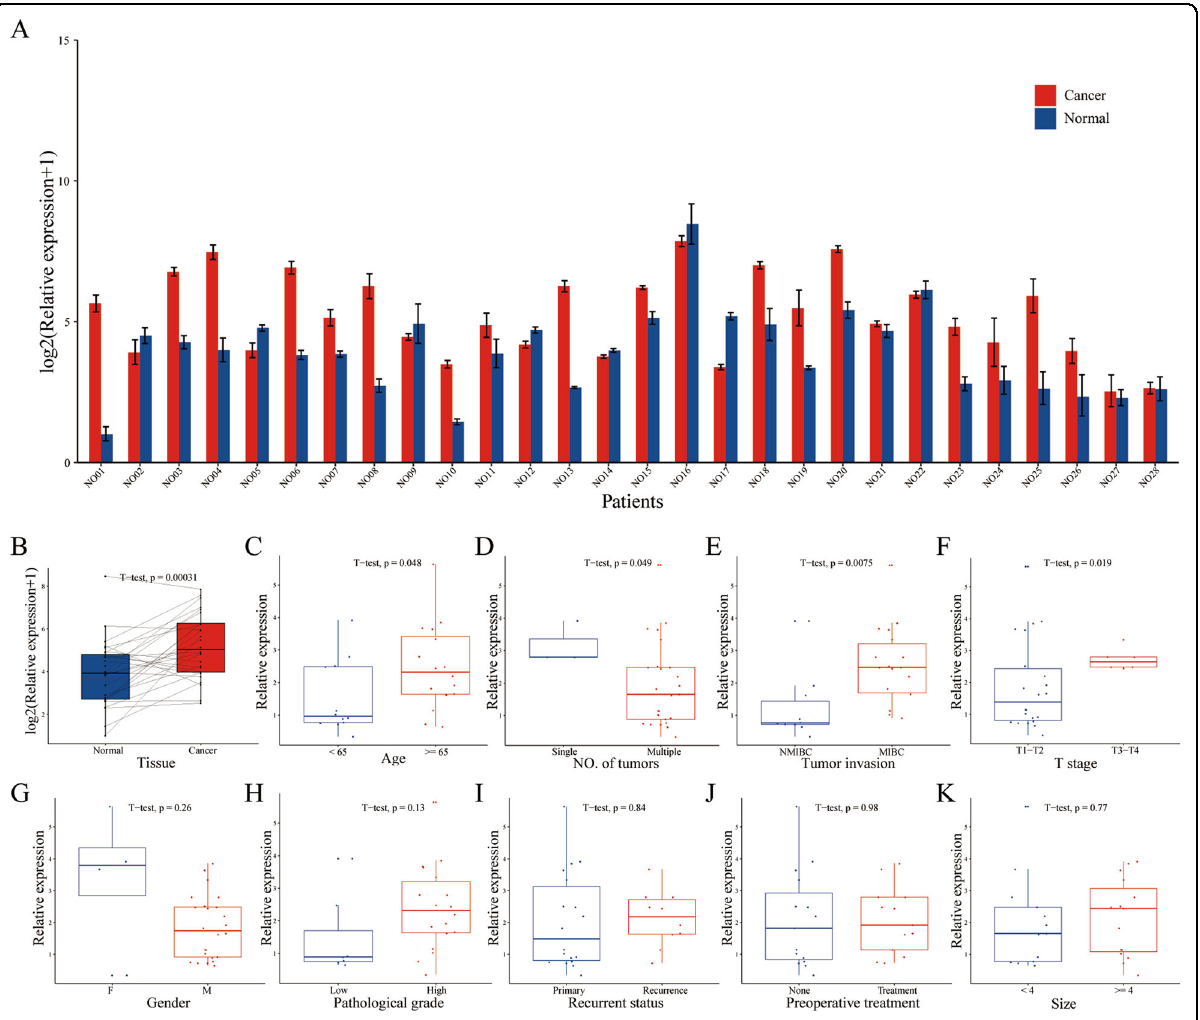
Fig. 1 PlncRNA-1 expression levels in BC tissues. A , B The expression level of PlncRNA-1 in 28 pairs of normal and BC tissues. C – K The correlation between BC tissue-PlncRNA-1 expression and age, number of tumors, tumor invasion, T stage, gender, pathological grade, recurrent status, preoperative treatment, and tumor